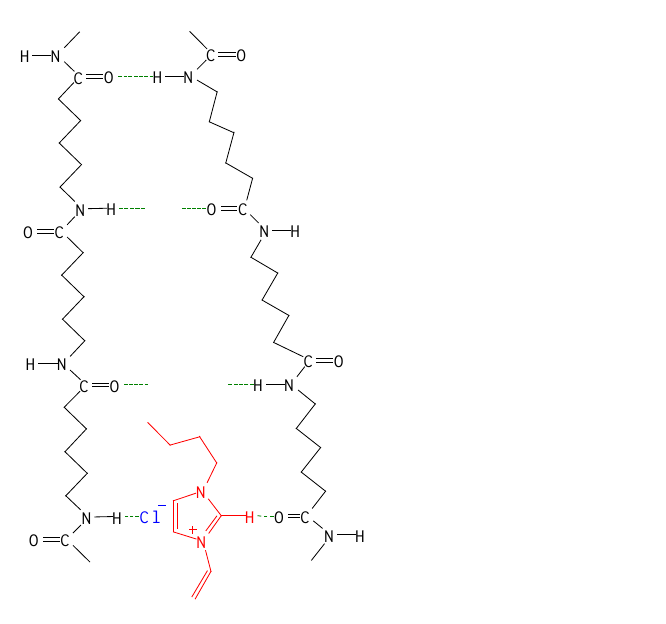
Figure S1. Elemental mapping distribution of PA6, PA6/VBIM, 4 wt % blend (labelled as 4%) and PA6/VBIM, 8 wt % blend (labelled as 8%); Figure S2. The DSC curves of neat VBIM; Figure S3. The plot of N–H width at half height in IR as a function of temperature; Figure S4. FTIR spectra of: (a) neat PA6, VBIM, and PA6/VBIM blends; (b) zoomed area of the N–H stretching band; and (c) zoomed area of the amide I band; Table S1. Basic tensile properties of the neat PA6 and PA6/VBIM